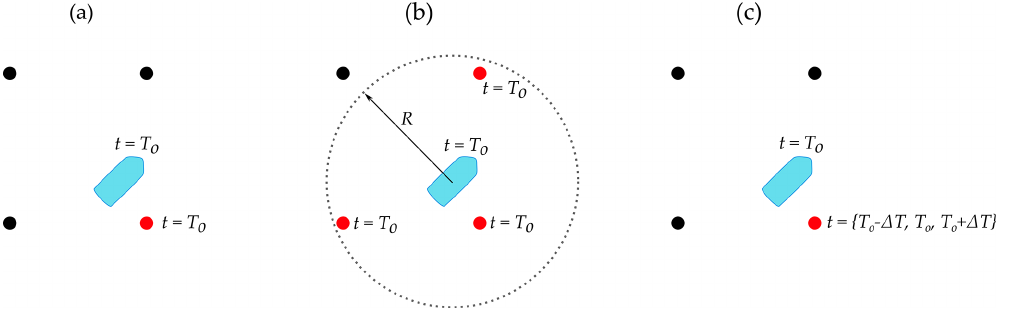
Figure 12. Sketch of the three cases considered to evaluate the temporal and spatial shift of the reanalyses. For each case, the ship and the surrounding grid points are included. The grid point(s) used for comparison against the measurements is/are colored in red. The timestamps used for comparison are also indicated.